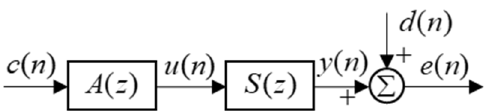
Figure 3. Simply expressed block diagram of the ASE algorithm.